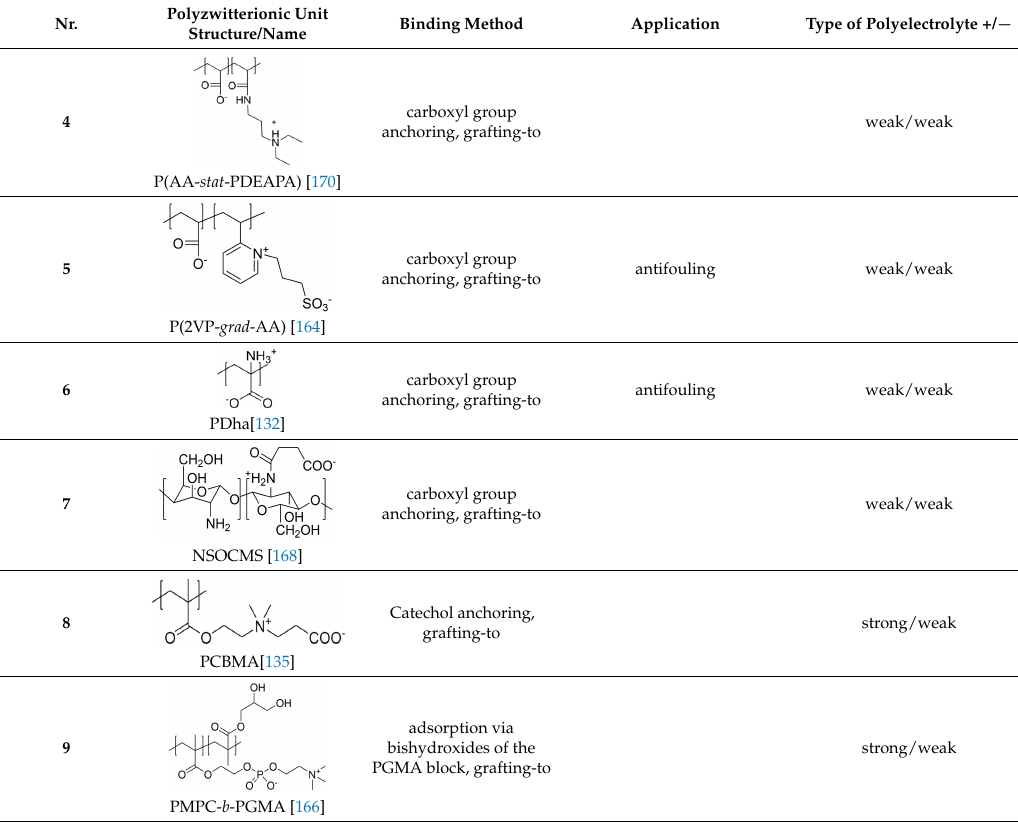
Table 2. Structures, binding method, potential application (if provided) and type of polyelectrolyte combination for polyzwitterions which were used for adsorptive surface functionalization of MNP. Nr.